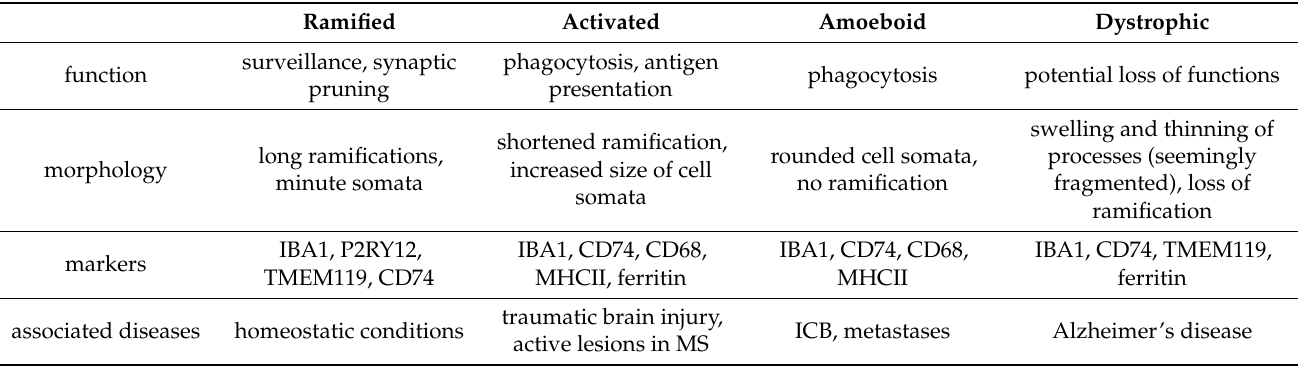
Table 1. Morphological microglial